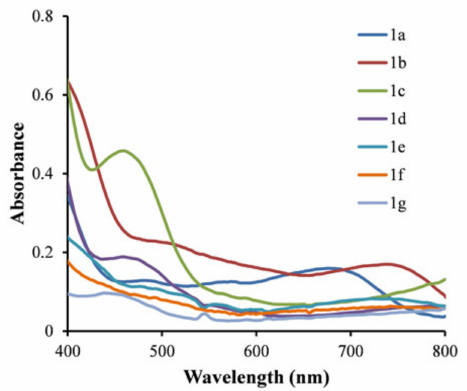
Figure 5. UV-Vis spectra of the compounds 1a–1g after electrochemical